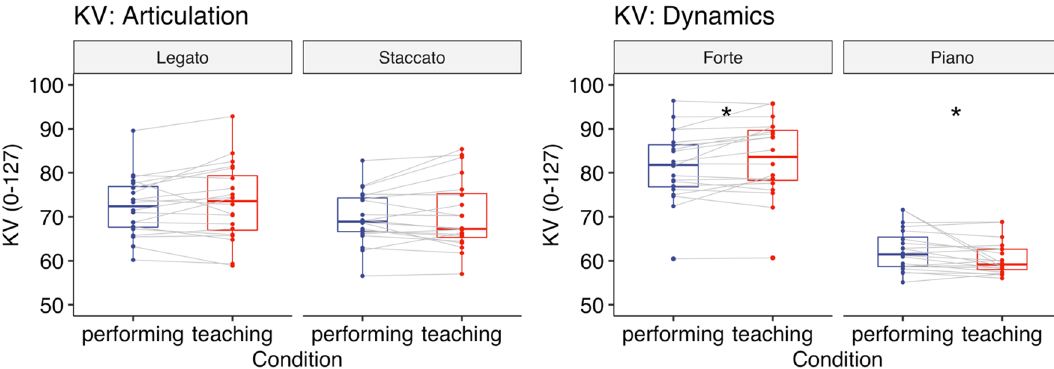
Figure 8. Experiment 2: KV (0–127) when playing the piece with either articulation (left) or dynamics (right). Each box indicates the IQR with the median, and whiskers extend to a maximum of 1.5 × IQR beyond the box. Significance levels: * < 0.05, ** < 0.01, *** < 0.001.